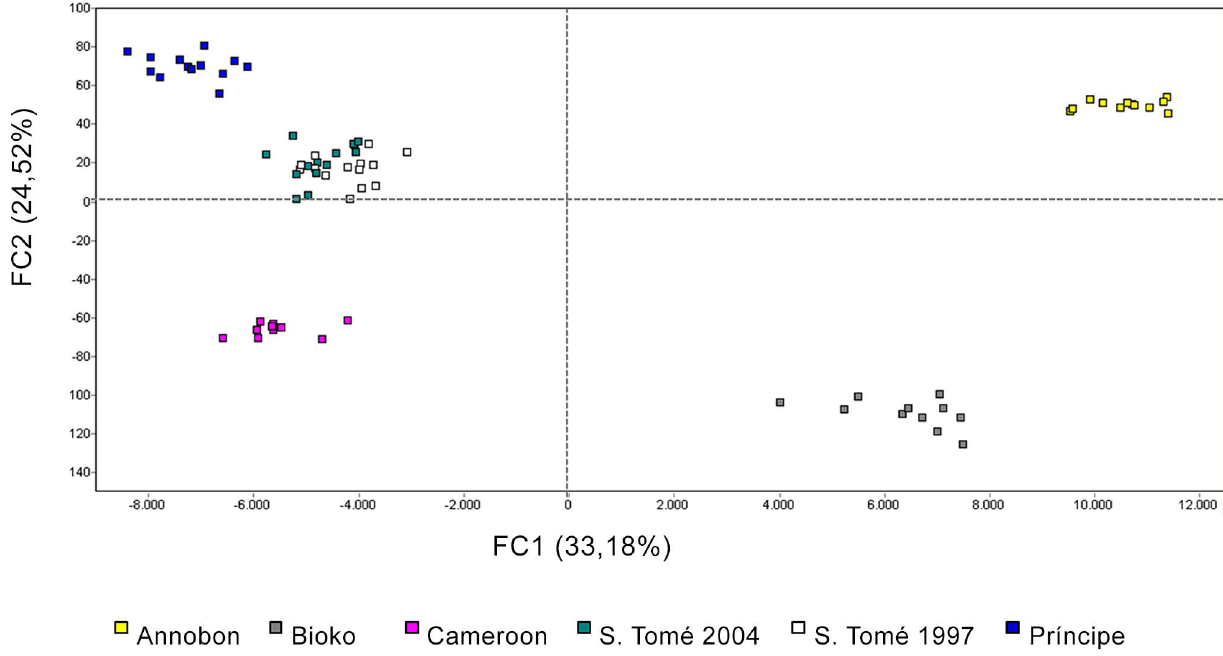
Figure 2. Projection of 81 individual Herves genotypes of Anophelesgambiae on the principal axes of a factorial component analysis. Each colour corresponds to a sampled island population as indicated in the legend. Inertia percentage values are presented for each factorial component (FC1 and FC2).